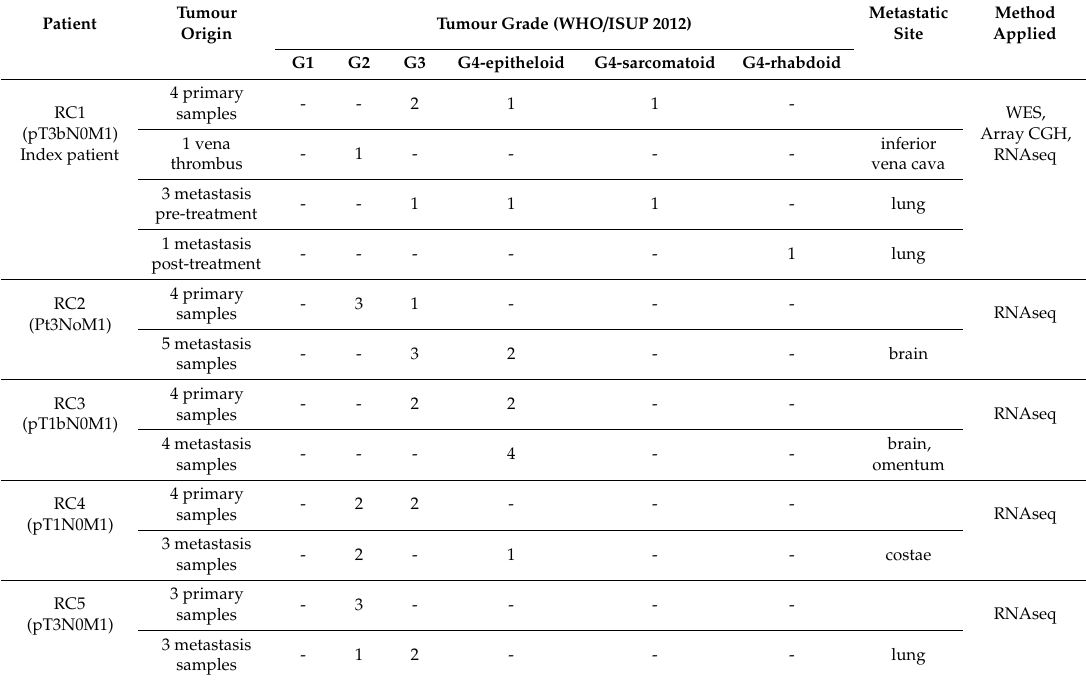
Table 1. Tumour sample